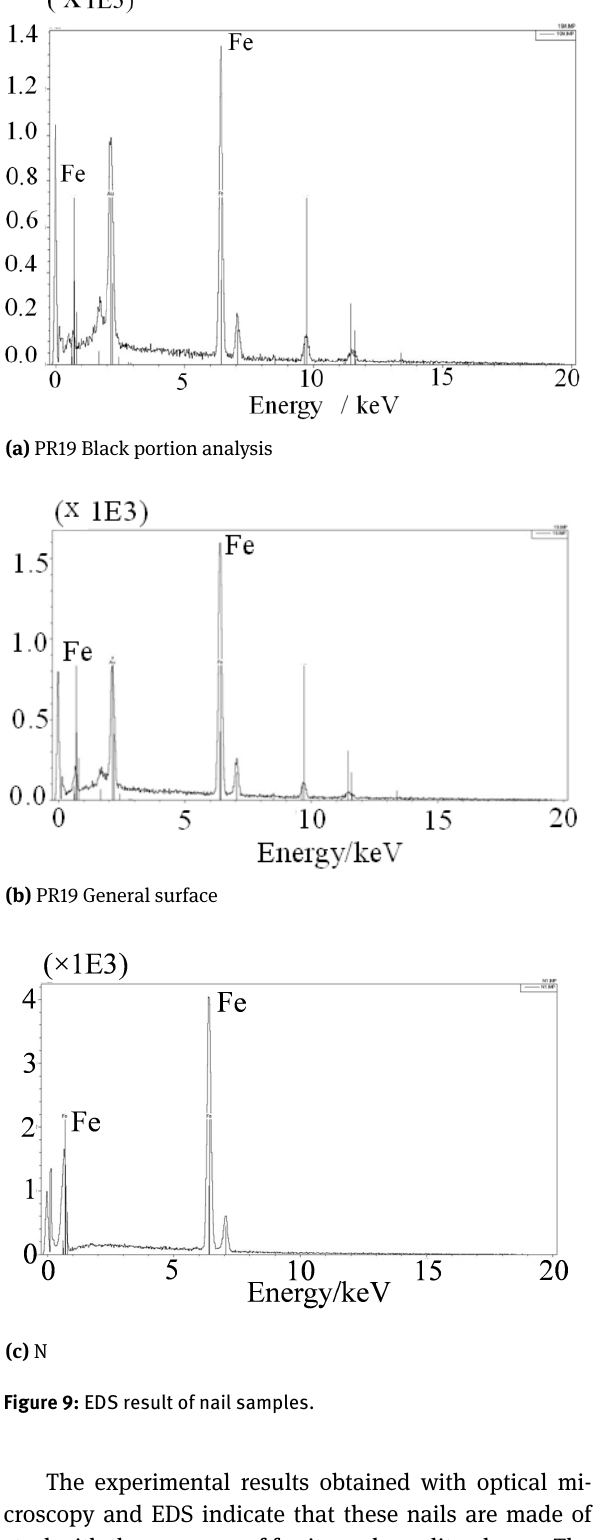
The experimental results obtained with optical mi- croscopy and EDS indicate that these nails are made of steel with the presence of ferrite and pearlite phases. The chemical analysis also indicate that black spots present in the microstructure surface of these nails are also